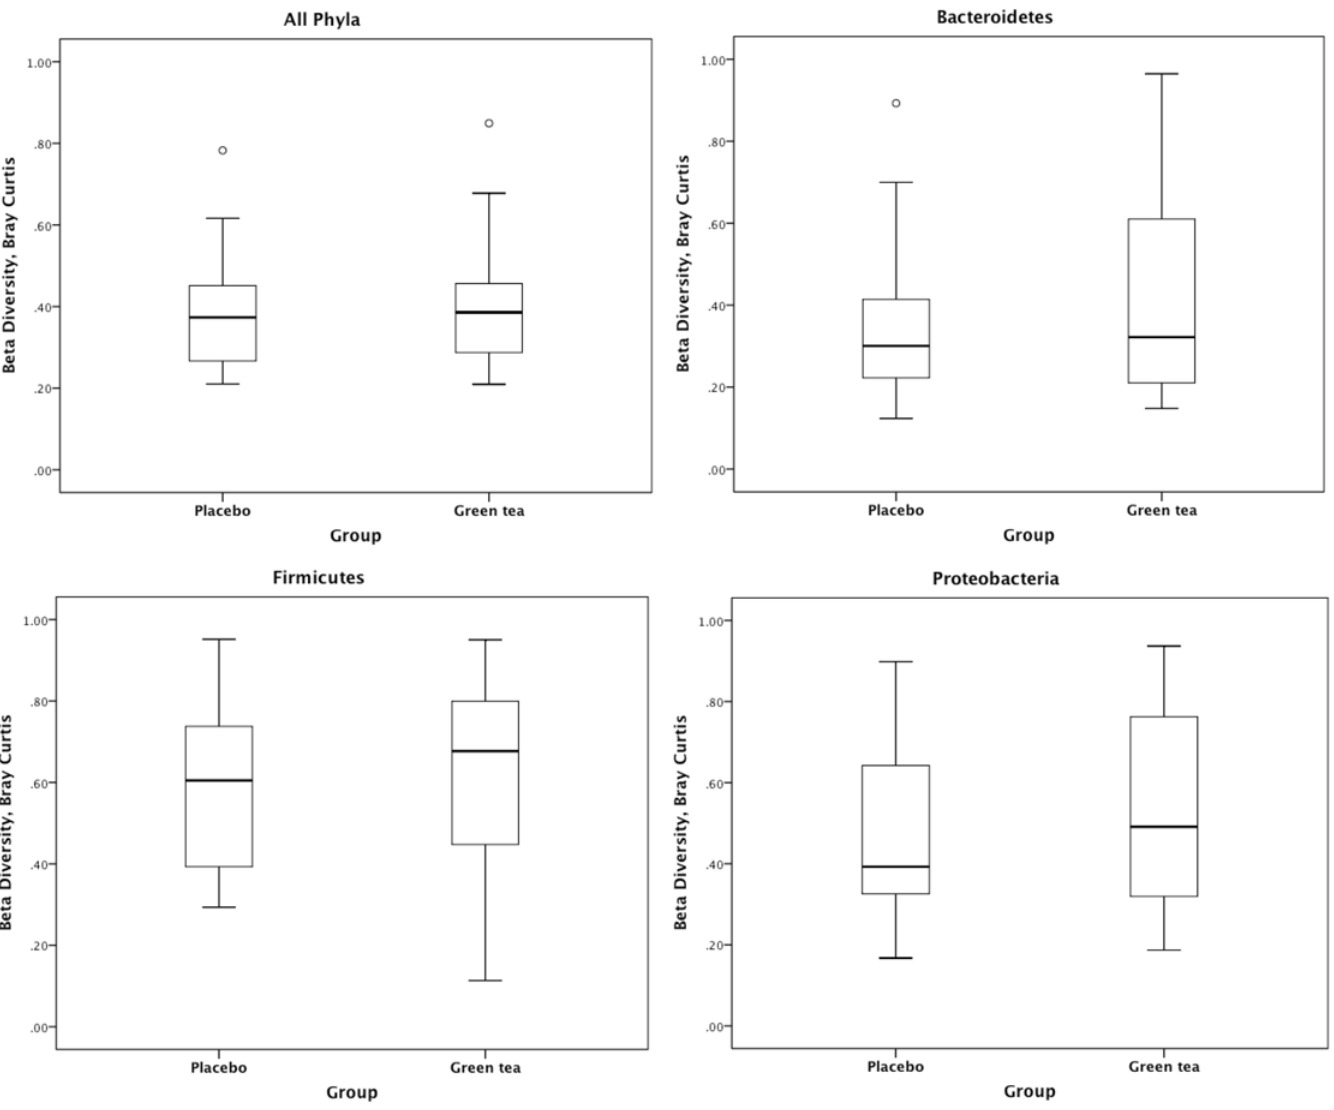
Fig 3. Box plots, comparisons of the between-sample diversity in green tea and placebo as calculated by Bray Curtis dissimilarity. Beta diversity captures the dissimilarity in microbial composition of the groups between baseline and week 12.